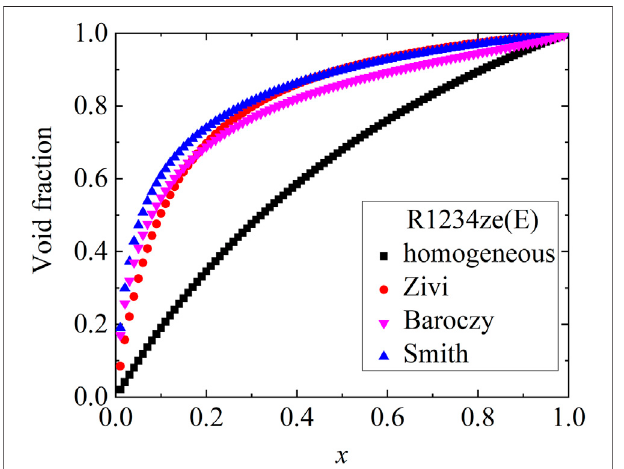
FIGURE 5 | Heat transfer coef fi cients in pristine and expanded micro- fi n